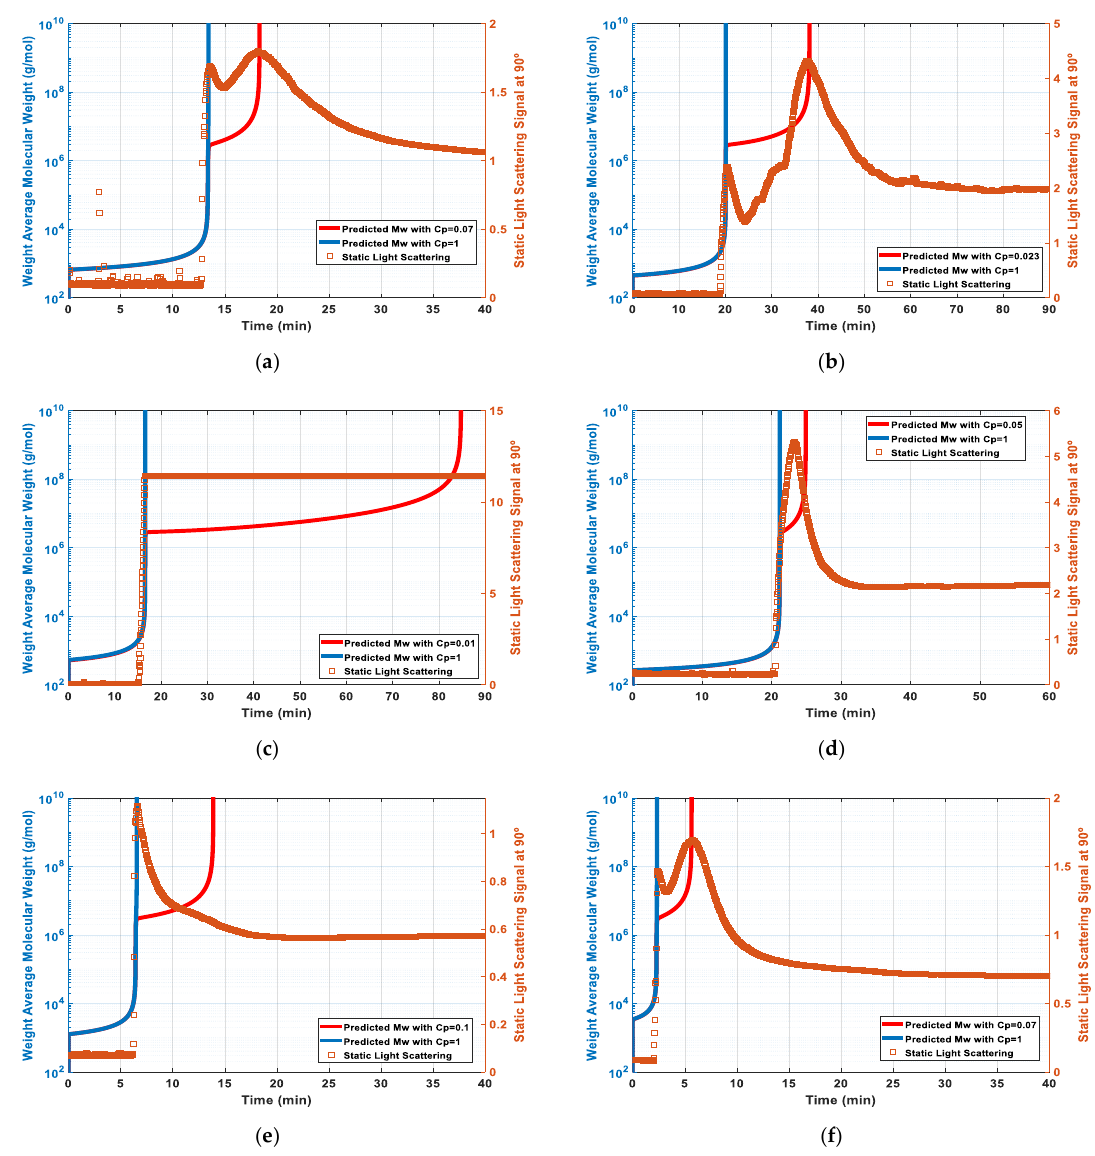
Figure 8. Predicted time-evolution of weight-average molecular weight ( 𝑀̅ 𝑤 ) and in-line measured static light scattering signal during AAm/MBAm hydrogel formation. Predictions considering two different values for the reactivity of the pendant double bonds ( 𝐶 𝑝 ) are here compared. ( a ) hydrogel H1, ( b ) H2, ( c ) H3, ( d ) H4, ( e ) H5, and ( f ) H6 (see Table 1).